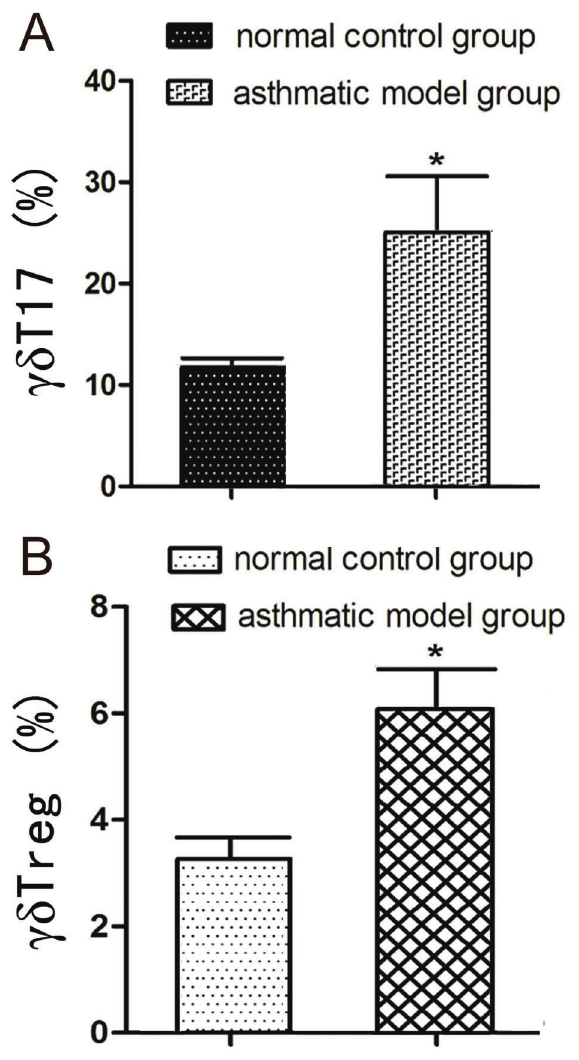
Figure 7. Comparative analysis of gd T17 cells ( A ) and gd Treg cells ( B ). Data are reported as means ± SD (n=6). *P o 0.05 vs normal control group ( t -test).